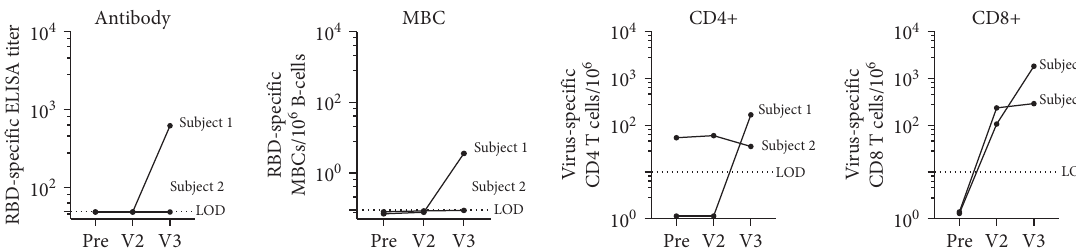
Figure 1: Immune response to COVID-19 vaccination in CLL subjects. RBD-specific antibody titer. Subjects without a detectable antibody titer ( < 1: 50 serum dilution) were assigned a value of 49. The limit of detection (LOD) is 50. Frequency of RBD-specific MBCs per 10 6 CD19+ B-cells following ex vivo stimulation. Subjects who did not have a detectable response were assigned a value between 0.07 and 0.09. The limit of detection (LOD) is 0.1. SARS-CoV-2 spike peptide-reactive CD4 and CD8 T-cells are defined as double positive for IFN c and TNF α cytokine secretion. Patients who did not have a detectable T-cell response were assigned an arbitrary number less than 2. The limit of detection (LOD) is 10. Visit 1 (pre) blood draw was taken 21 and 40 days prior to the Pfizer vaccine series (2-doses). Visit 2 (V2) blood draw was taken 33 and 24 days post vaccination, and Visit 3 (V3) was drawn 30 and 27 days after the 3rd vaccination with